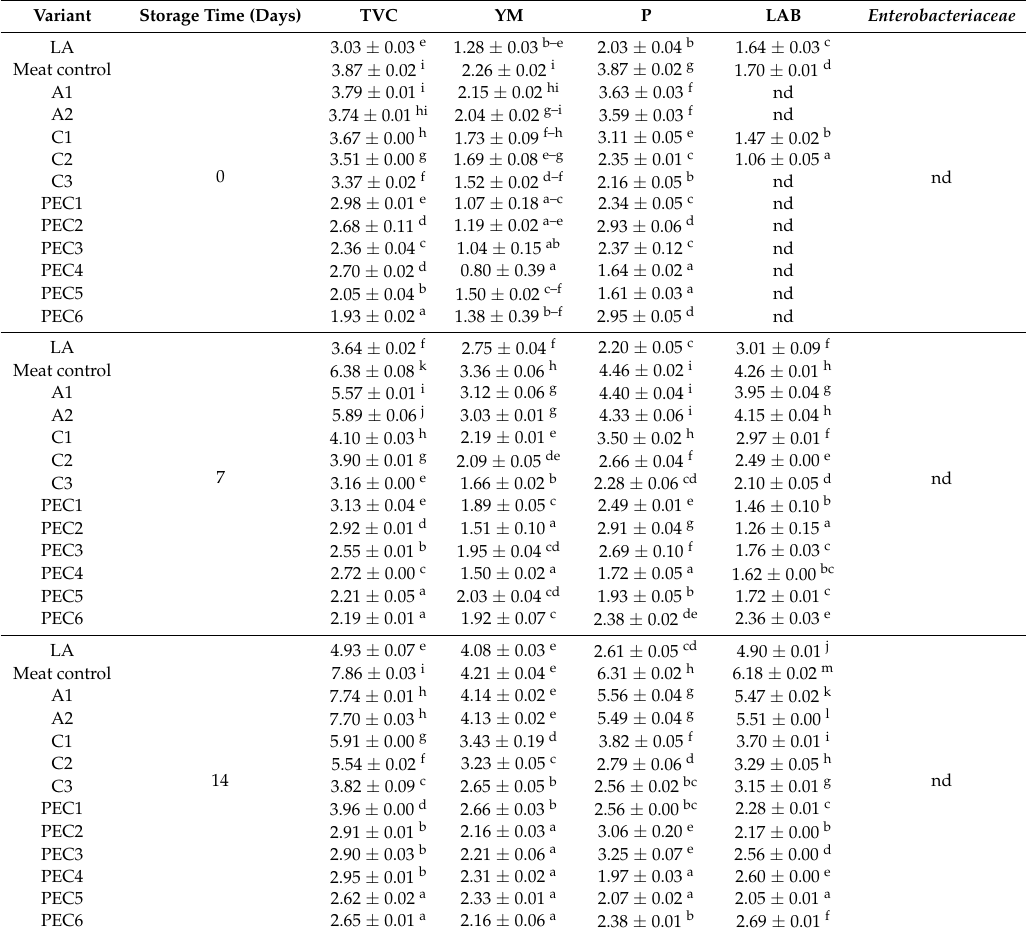
Table 2. The effect of sodium alginate (A1, A2), chitosan (C1, C2, C3), sodium alginate-chitosan complex (PEC1-PEC6), and 0.5% lactic acid solution (LA) application on surface microbiota of raw pork meat during 0, 7, and 14 days of chill storage.